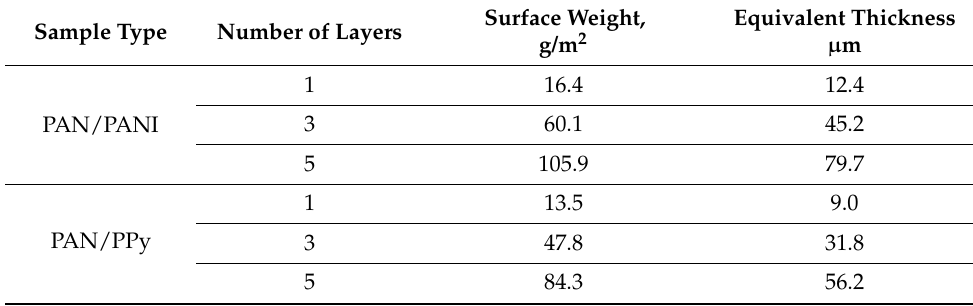
Table 1. Characteristics of PAN samples vs. number of PANI or PPy layers.